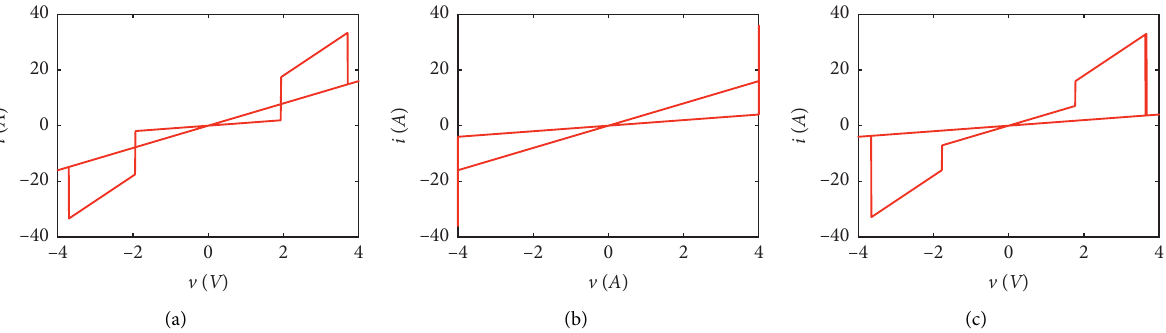
Figure 5: v-i curve of tri-valued memristor at different input signals: (a) sine wave, (b) square wave, and (c) triangular